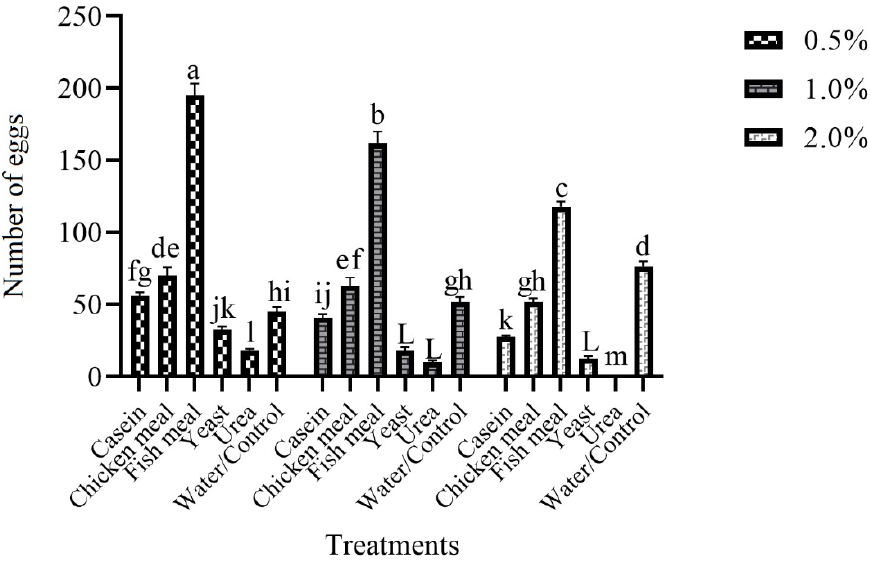
Figure 3. The interaction of attractive materials and concentration in black ovitraps in the laboratory. These letter shows significant difference among treatments.